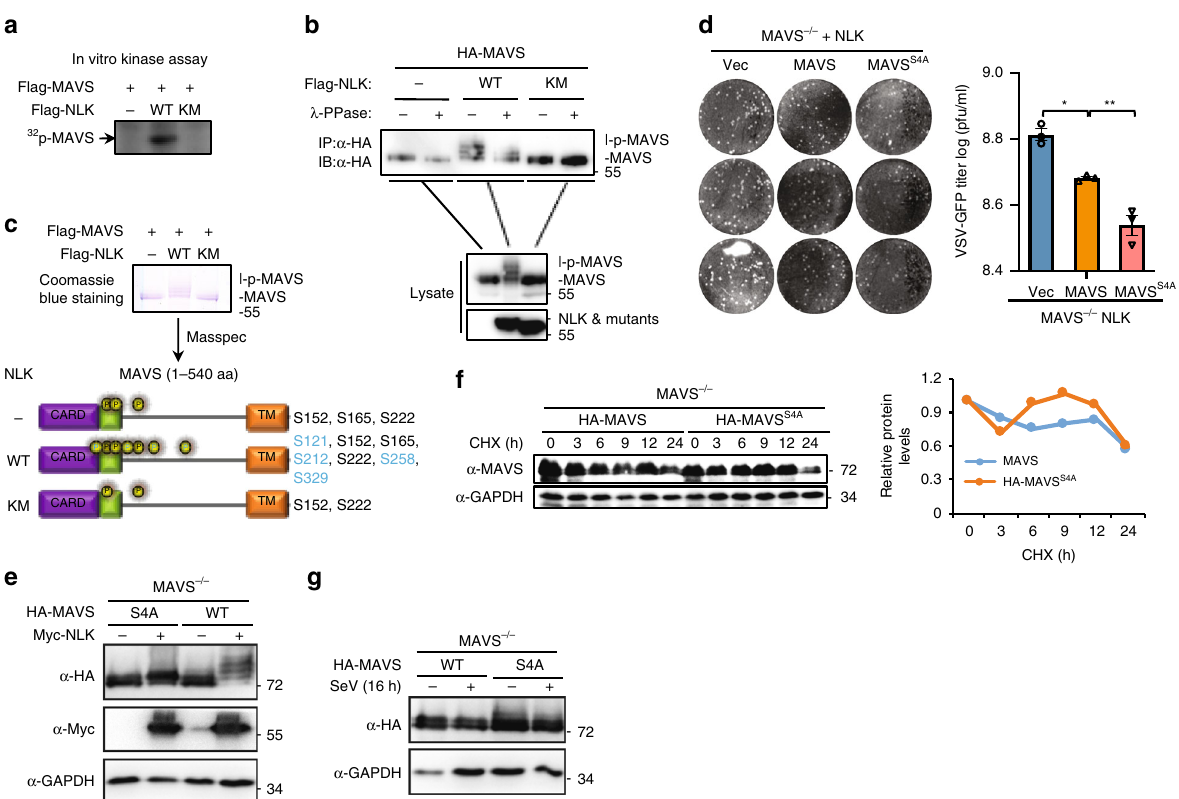
Fig. 7 NLK phosphorylates MAVS and alters proteasome-dependent degradation. a Phosphorylation of the MAVS protein by NLK in vitro. HEK293T cells were transfected with the indicated expression vectors. The protein immunoprecipitated with the anti-Flag antibody was incubated with [ γ - 32 P] ATP. The phosphorylated proteins were visualized through autoradiography. b The NLK-dependent mobility shift of MAVS due to phosphorylation. The proteins immunoprecipitated with the anti-HA antibody were incubated with γ -PPase. The samples were analyzed via immunoblot using the indicated antibodies. c Phosphorylation sites of MAVS as detected by Masspec in the absence or presence of NLK or NLK KM . The proteins immunoprecipitated with the anti- Flag antibody were subjected to SDS-PAGE and stained with Coomassie blue following mass spectrometry analysis. The phosphorylation sites are shown in the graphs. The highlighted sites are speci fi c for the presence of NLK (bottom panel). d Effects of MAVS or MAVS S4A in MAVS − / − HEK293T cells expressing NLK on the antiviral response. MAVS − / − HEK293T cells were transfected with NLK and MAVS or MAVS S4A and then infected with VSV-GFP at an MOI of 1, and the supernatants were added to Vero cells. After fi xation, cells not killed by the virus were stained with crystal violet (left panel), and the viral titer was then determined (right panel) ( n = 3). e Effects of NLK on MAVS and MAVS S4A . MAVS − / − HEK293T cells were transfected with the indicated plasmids, and cell lysates were analyzed via immunoblot. f Stability of MAVS and MAVS S4A in MAVS − / − HEK293T cells. The cells were treated with CHX for the indicated periods and then subjected to immunoblot analysis. The relative levels of MAVS were calculated after normalization to GAPDH. g Effect of SeV-induced MAVS degradation on wild-type HA-MAVS and HA-MAVS S4A . MAVS − / − HEK293T cells were transfected with HA-MAVS and MAVS S4A , after 12 h, incubation with SeV for another 16 h. The cell lysate was then analyzed via immunoblot using the HA antibody. MAVS S4A : Serine 121/212/258/329 to Alanine. Data are representative of three independent experiments. Data are presented as the mean ± SEM. Statistical signi fi cance was analyzed by ANOVA or Student ’ s t -test (* p < 0.05, *** p < 0.001). Source data a – g are provided as a Source Data fi